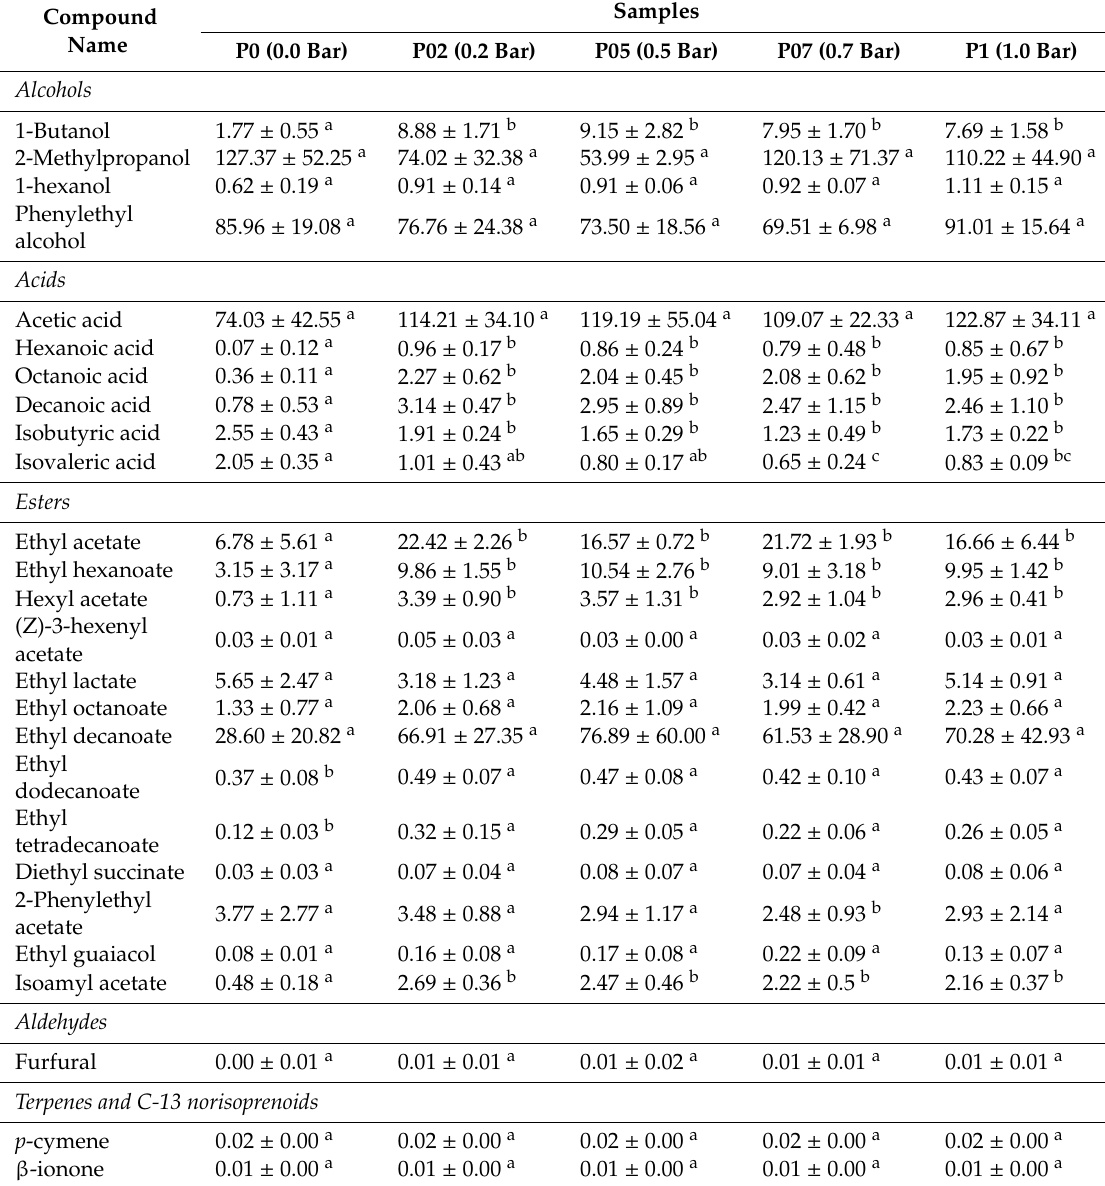
Table3. Meansandstandarddeviationsofquantifiedaromaticcompounds( p < 0.05). Concentrationsare expressed in mg / L. The presence of di ff erent letters indicates statistically significant di ff erences at Tukey honestly significant di ff erence (HSD) post hoc test, while the presence of the same letters means there were no statistically significant di ff